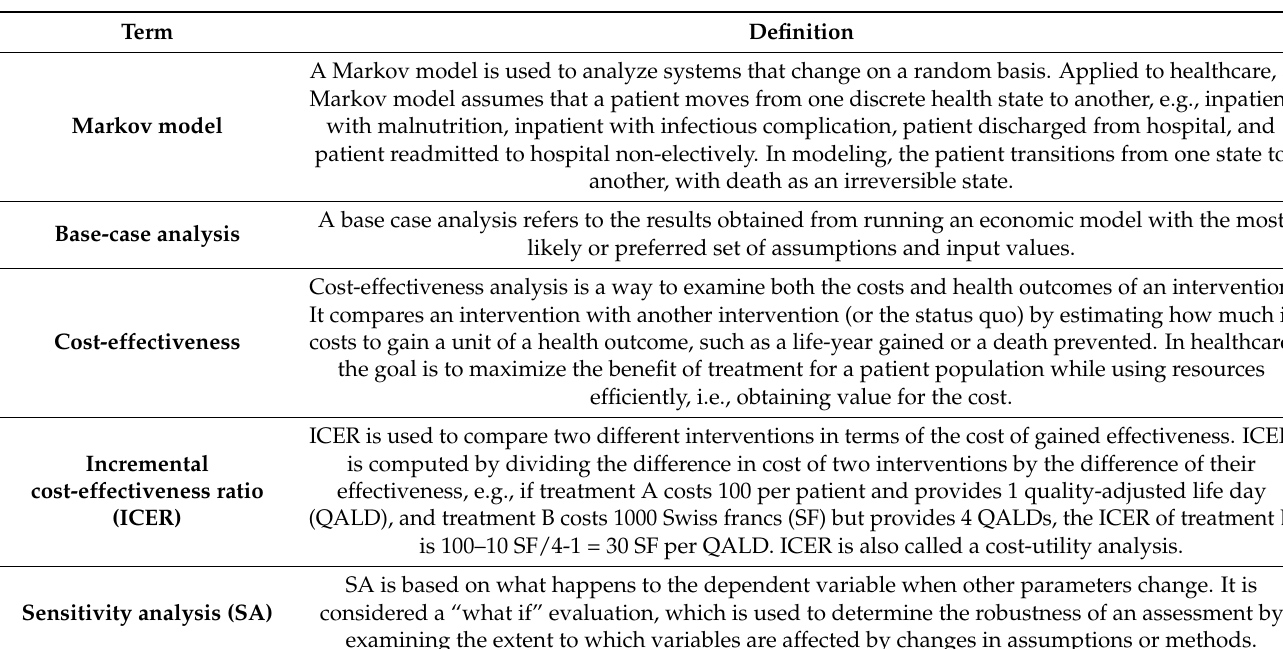
Table A1. Definition of terms used in health economic